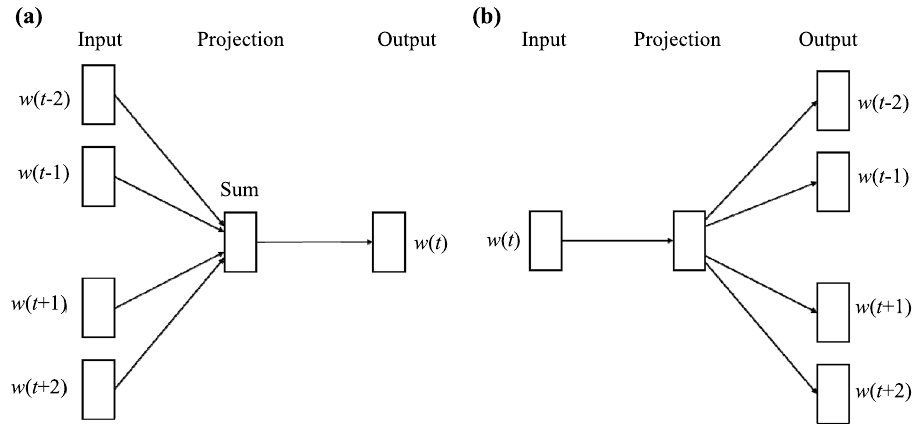
Fig. 5 CBOW and skip-gram neural network structure: a CBOW model; b skip-gram model